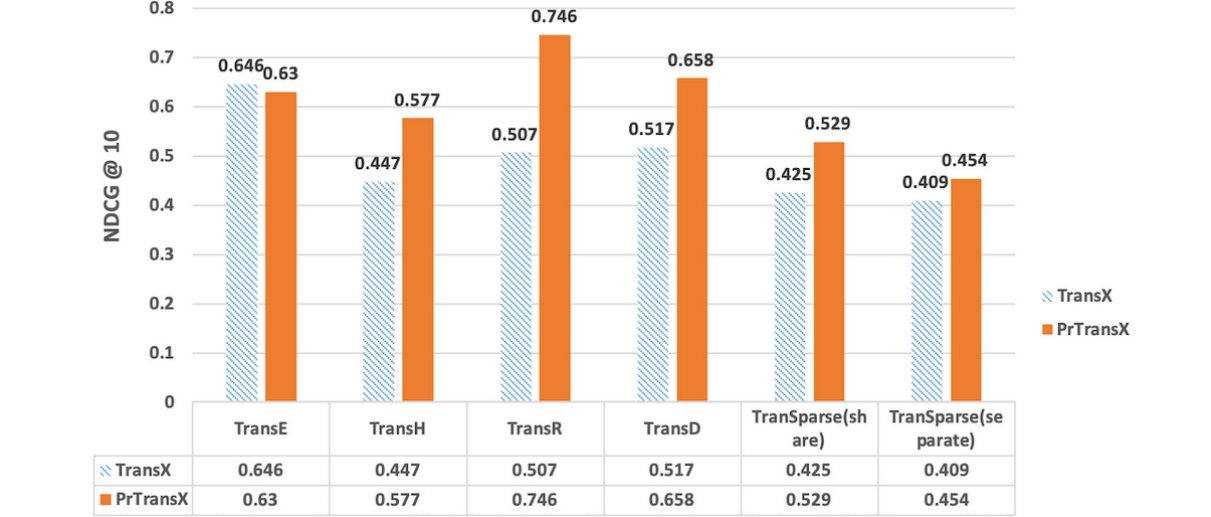
Figure 5. Normalized discounted cumulative gain of the top 10 predicted tail entities of the tested algorithms.